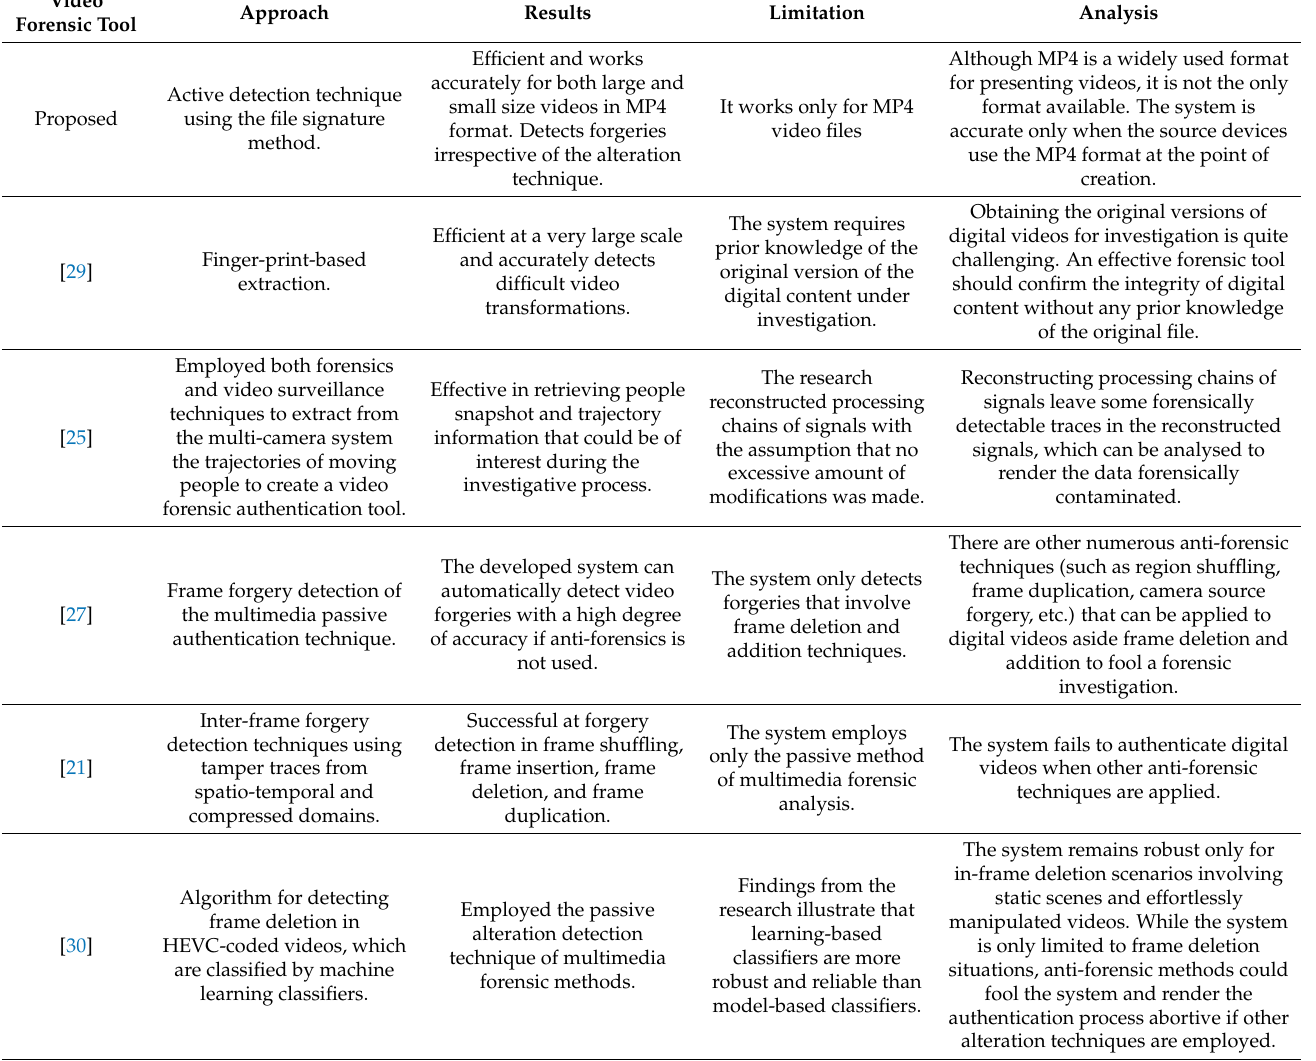
Table 6. Comparative analysis MP4 file forensic